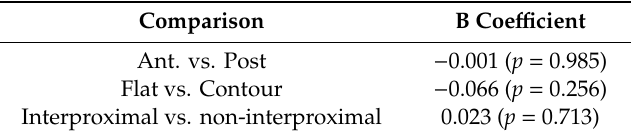
Table 3. Parameters that a ff ect the surface topography of the scanner by Univariate Linear Regression Analysis ( p < 0.05).